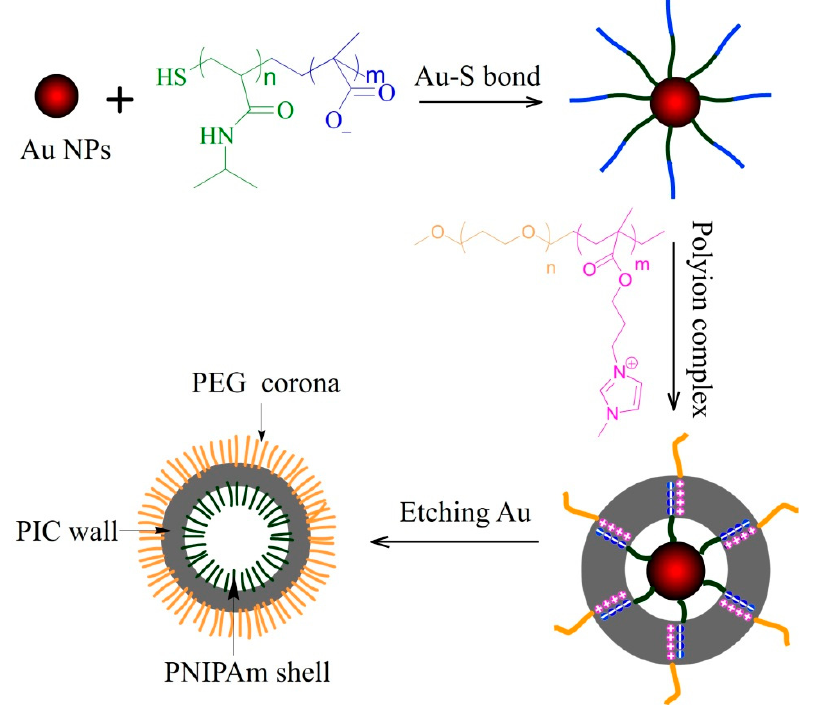
Figure 1. Schematic representation of the synthetic process of asymmetric PICsomes.